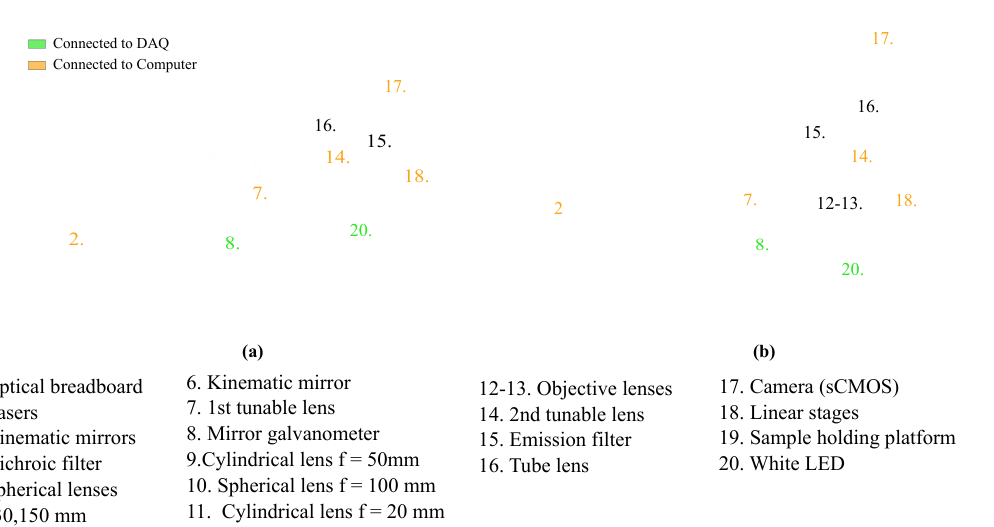
Figure 1. SPIM architecture and components. The model information for all numbered imaging components are listed in Table 1. Those controlled directly by the computer are labeled in orange and the ones controlled by the DAQ appear in green. ( a ) 3D model using Autodesk Fusion 360. CAD files for the components were obtained from the Thorlabs webpage and reproduced with